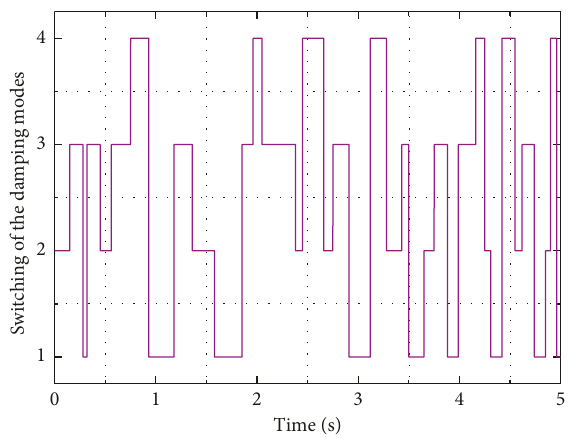
Figure 10: Switching of the damping